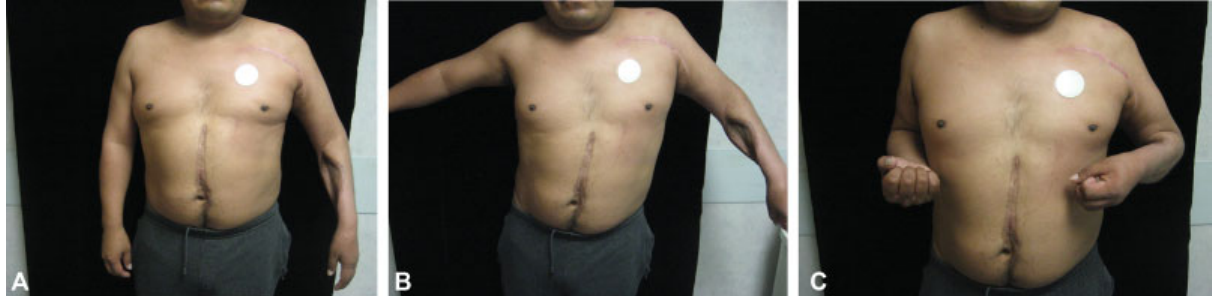
Fig. 2 Photograph of patient demonstrating postoperative shoulder range of